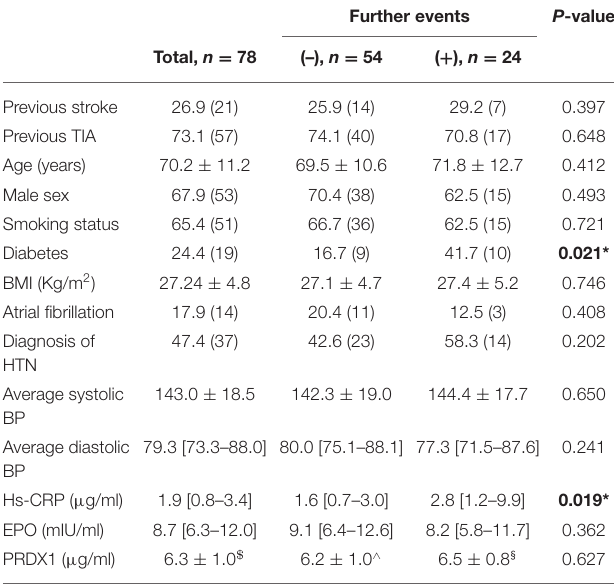
TABLE 1 | Descriptive analysis of patients and univariate analyses of variables associated with further ischemic events.